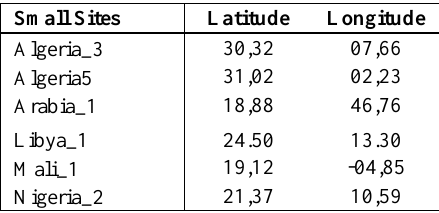
Table 1 : Position of the centre of the small